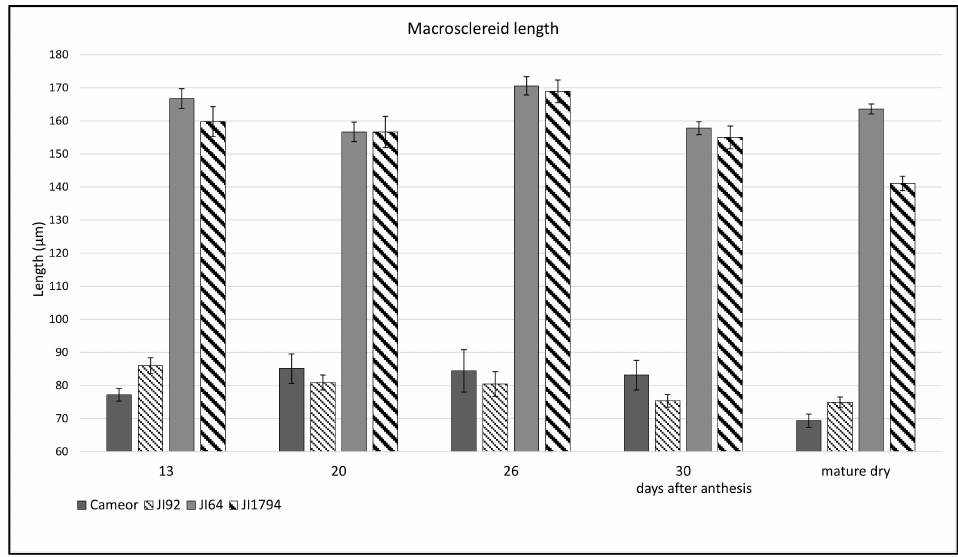
Figure 3. Length of macrosclereid cells during the seed coat development. Five seeds of each stage were sectioned and five sections per seed were measured. Mean and SD are